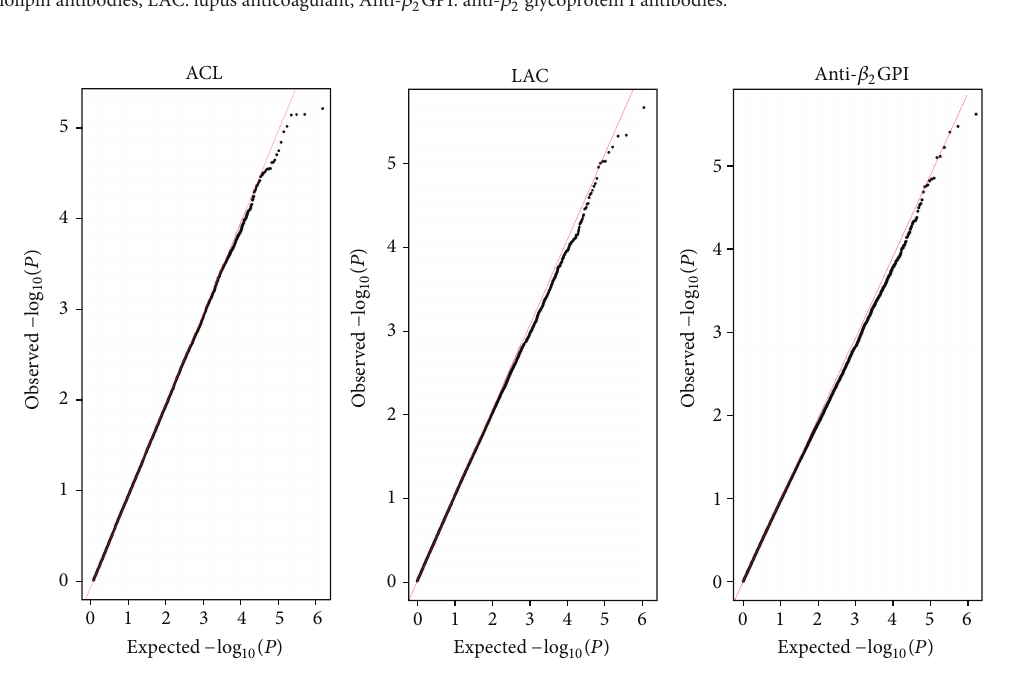
Figure 1: Quantile-quantile plots of the observed versus the expected 𝑃 values for ACL, LAC, and Anti- 𝛽 2